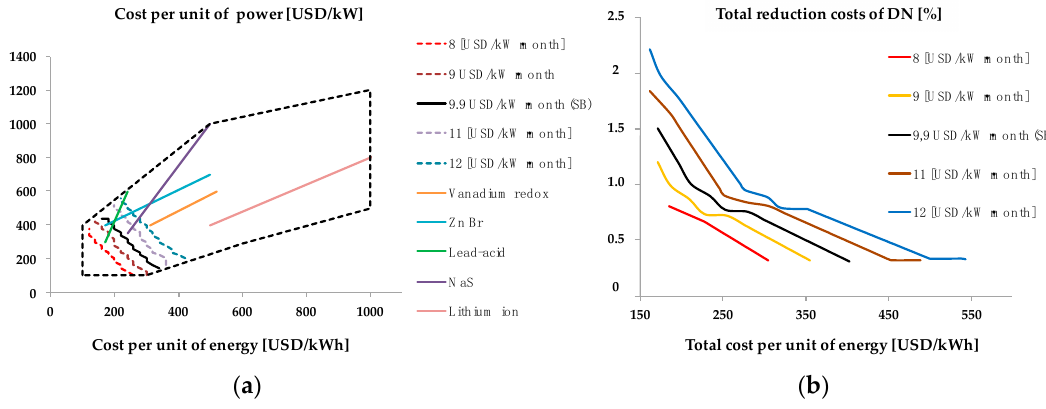
Figure 6. ( a ) Effects of the power price on the break-even costs and ( b ) Total cost reductions for the DN for different power prices.